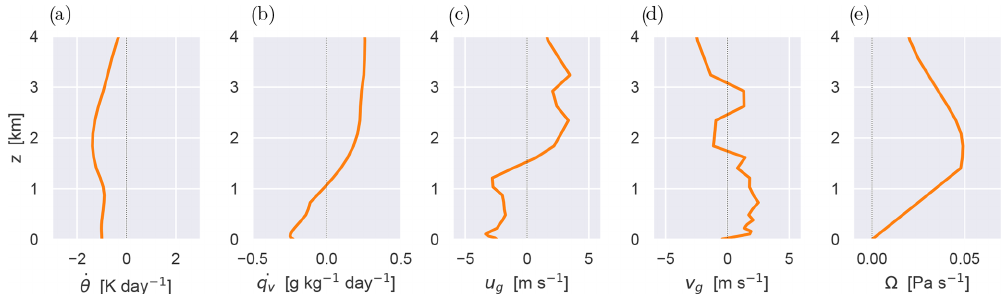
Figure A1. Profiles of the prescribed large-scale forcings based on ECMWF data.